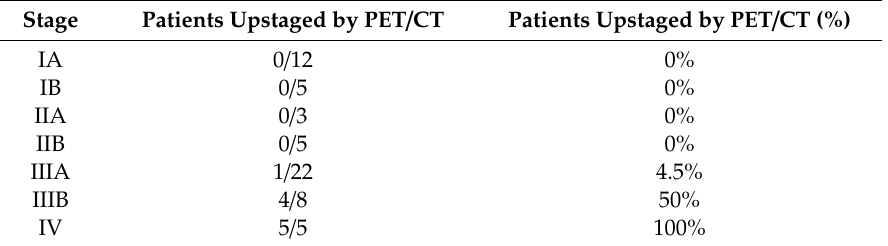
Figure 2. Diagnostic workup for MCC patients. Table 2. Impact of staging with PET-CT adapted from Hawryluk et al. [16].